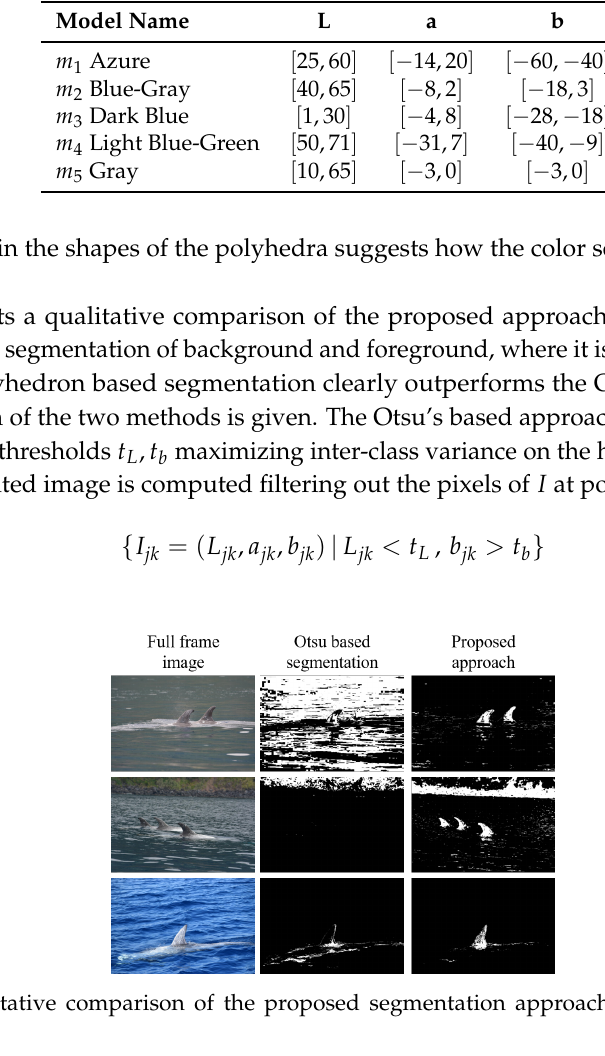
Table 1. Sea color sets specification.